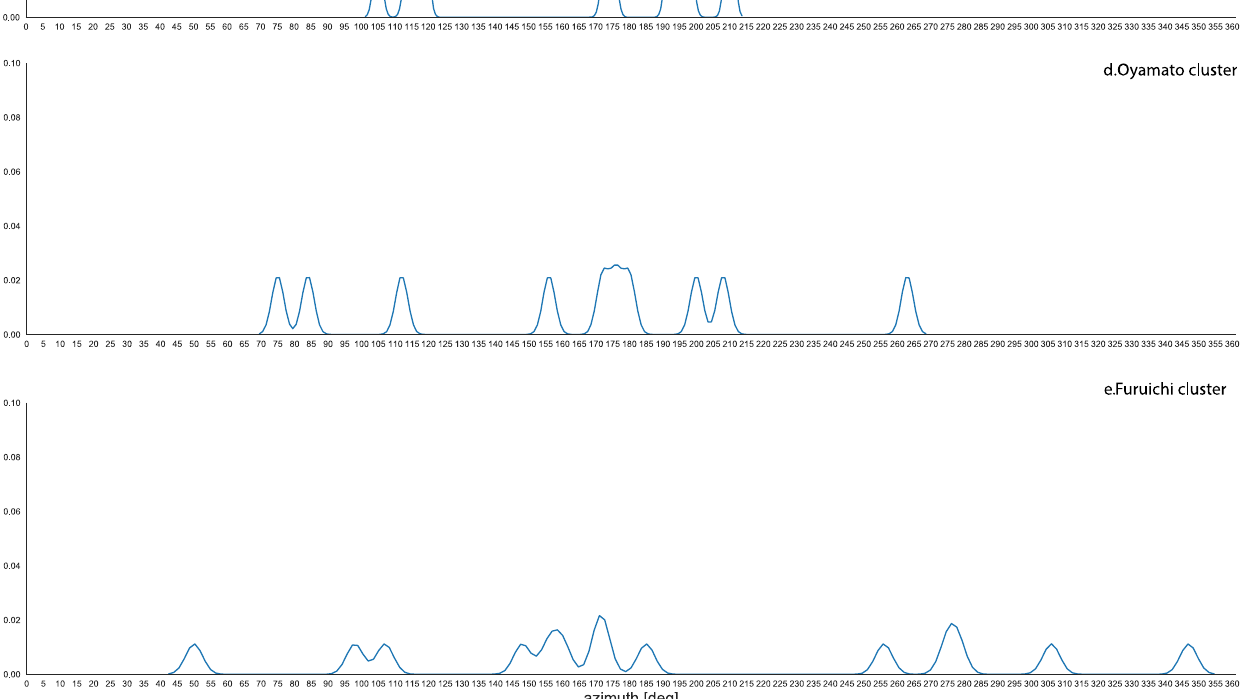
Figure 10. Kernel distribution of the orientations of keyhole Kofun in the Saki ( a ), Sakitama ( b ), Mozu ( c ), Oyamato ( d ), and Furuichi ( e ) clusters.